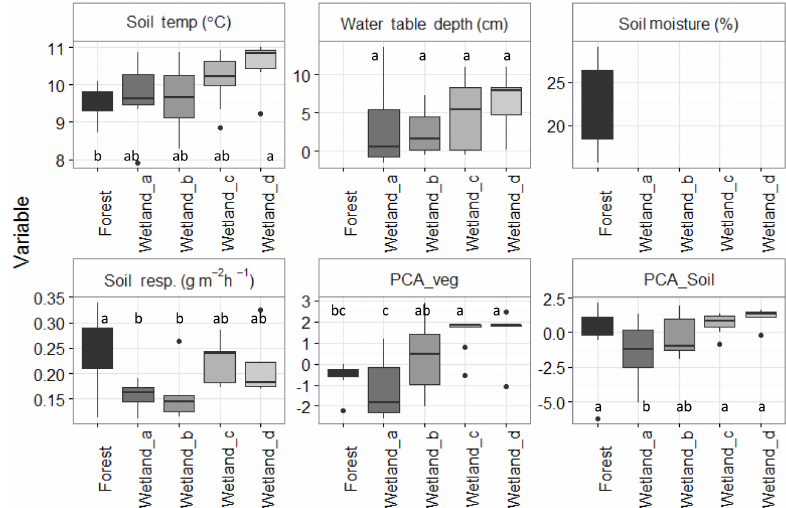
Figure 6. Box plots showing range of measured environmental variables within each of the CH 4 clusters. Letters represent results from the Tukey family test statistic where clusters with similar letters are not significantly different from one another at 95% confidence level. Clusters Wetland_a to Wetland_d represent groups with sequentially increasing CH 4 emissions. Note that water table was not measured within the forest plots; therefore the water table values given in the “forest” cluster actually represent only the two wetland chambers which have quantitatively been assigned to this cluster and have therefore been excluded.